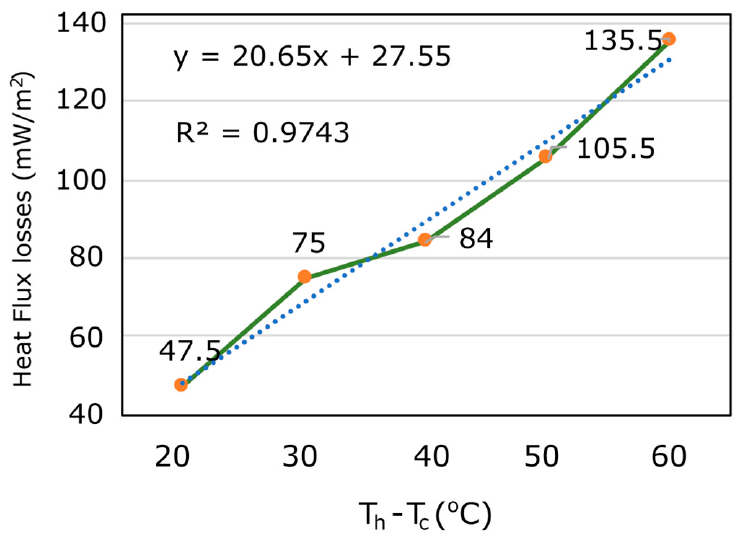
Figure 8. Lateral heat-flux losses as function of thermal gradient generated on a calibrated sample.